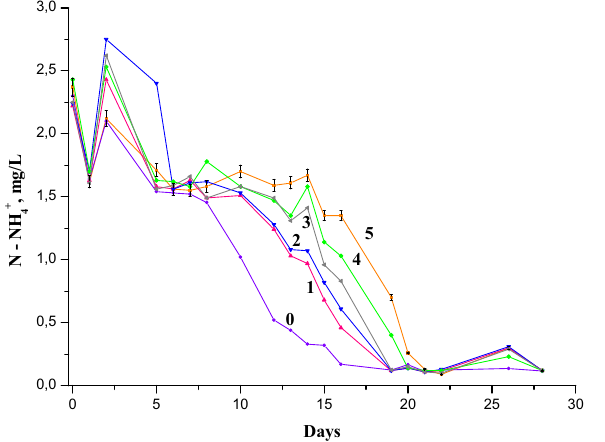
Figure 1. Dynamics of ammonium ions concentration in the Nistru River water containing 3 mg/L NH 4+ in the presence of 1-naphthylamine * : (0) 0 mg/L, reference sample; (1) 0.025 mg/L (0.5 MAC 1-NA); (2) 0.05 mg/L (1.0 MAC 1-NA); (3) 0.1 mg/L (2.0 MAC 1-NA); (4) 0.25 mg/L (5 MAC 1-NA); (5) 0.5 mg/L (10 MAC 1-NA). *The indicated chemical analysis tests were obtained through three replicates. Other curves on this figure contain